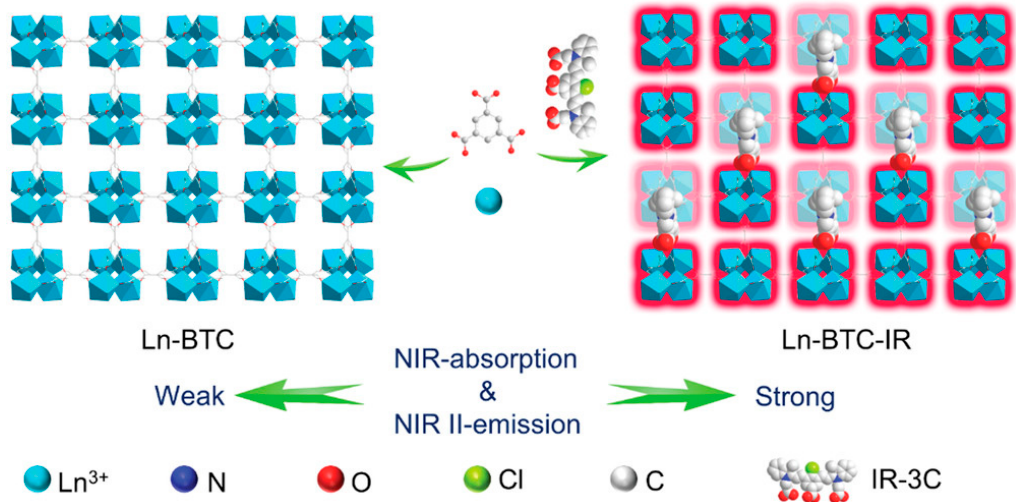
Figure 1. Schematic diagram of the fabrication of Ln-BTC-MOFs with strong NIR-II emission by a cyanine dye doping process. Reprinted with permission from [53]. Copyright 2022 John Wiley and Sons.